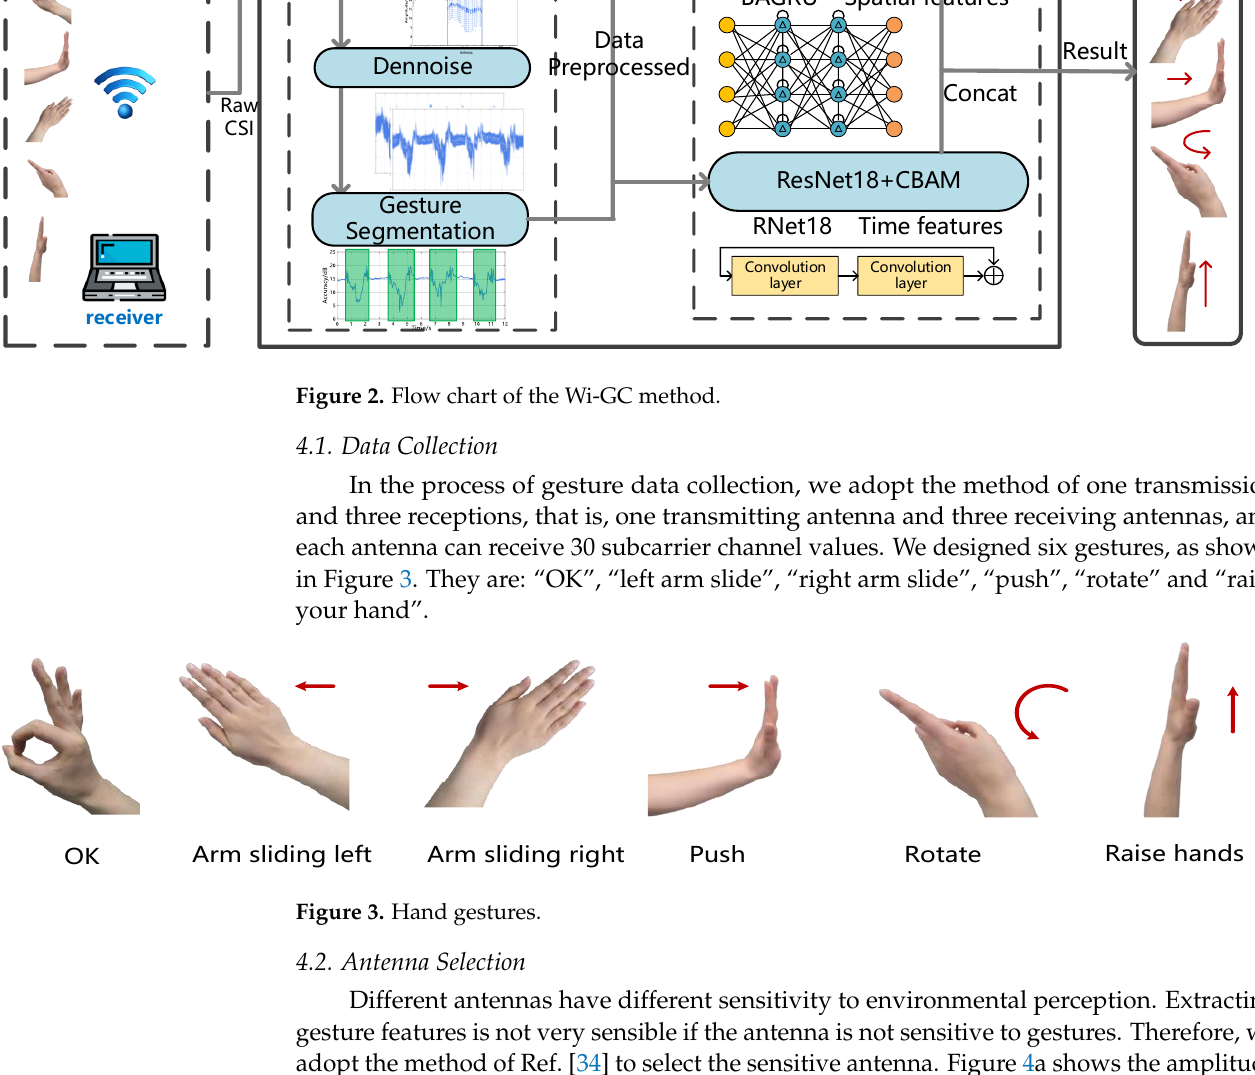
( b ) Figure 4. Antenna selection: ( a ) Comparison of the three antennas. ( b ) Subcarrier number one on three antennas. 4.3. Data Processing Due to the significant environmental noise when collecting data, denoising is re- quired. We chose the Kalman filter and Sym8 wavelet to process the noise of the collected raw CSI antenna data. The process of data processing is shown in Figure 5.